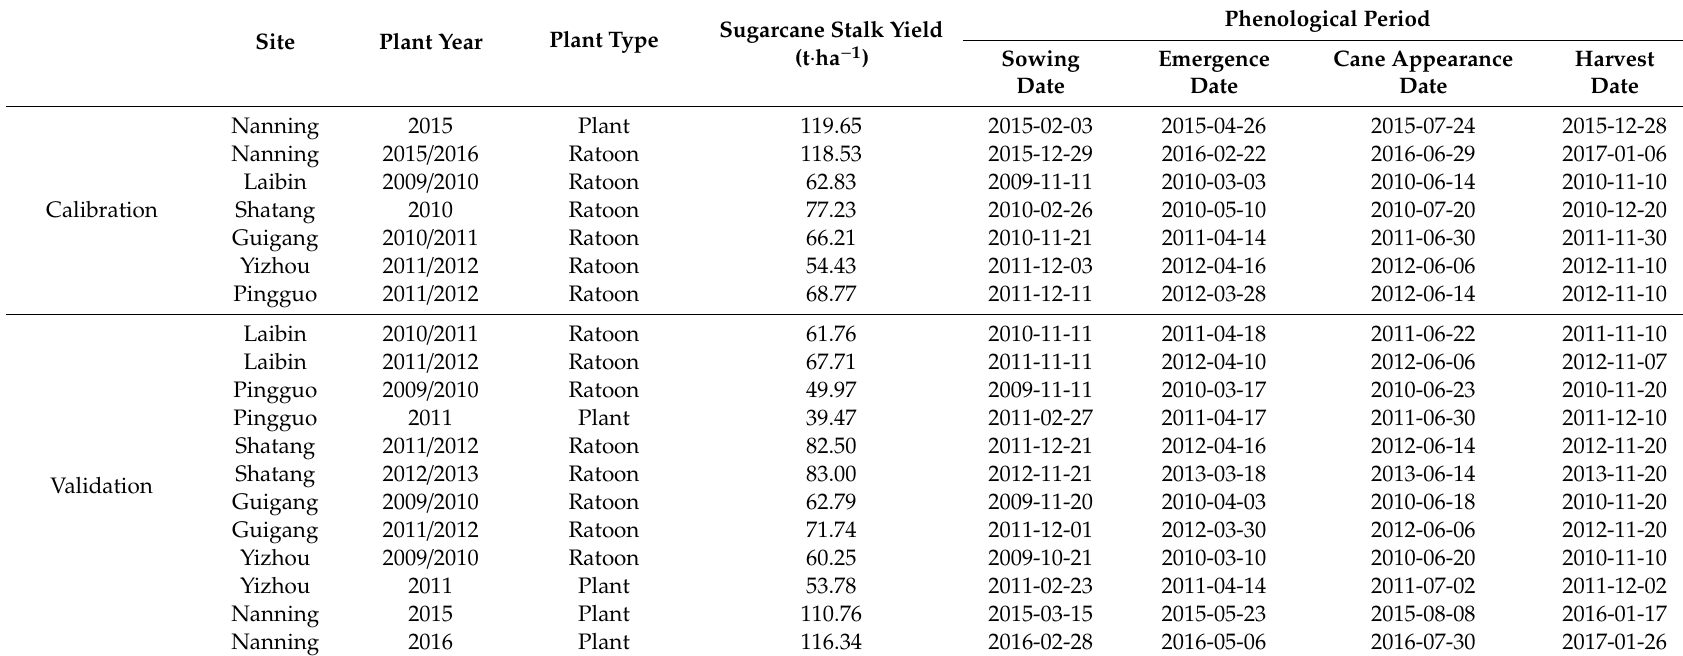
Table 3. Model calibration and validation data